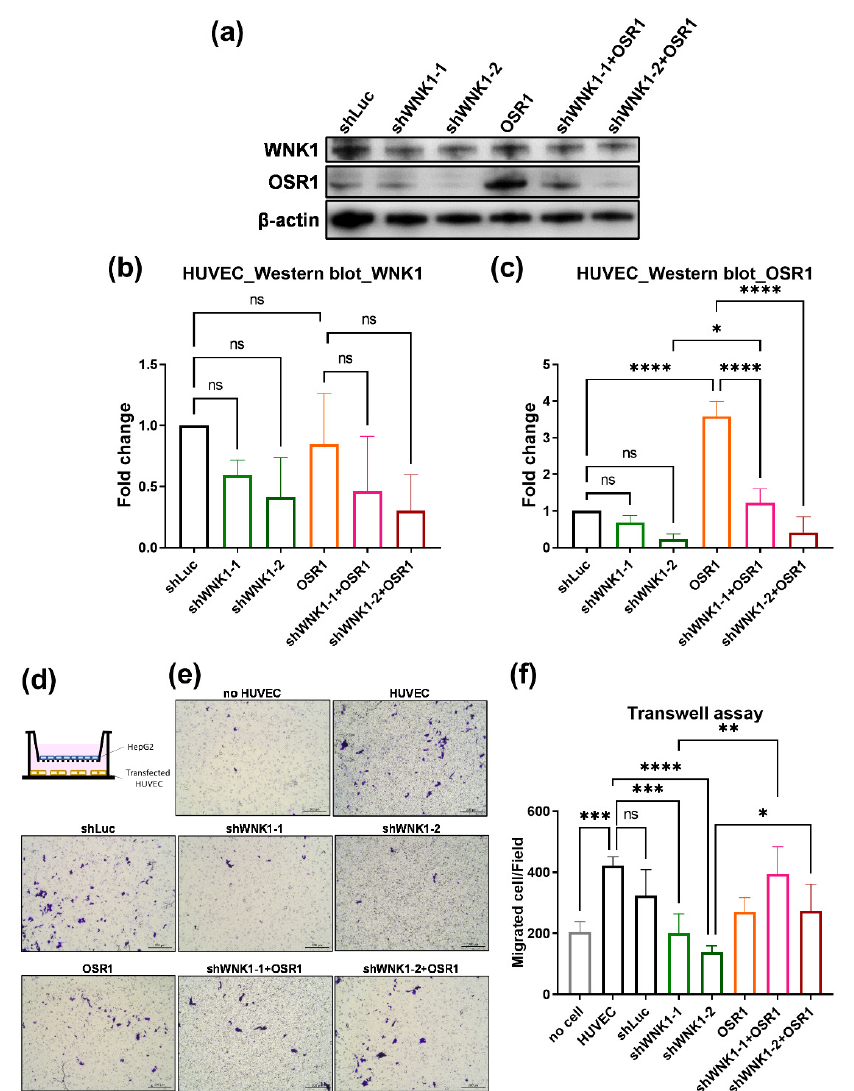
Figure 8. Knockdown of WNK1 in HUVEC cells significantly decreases the co-cultured hepatoma cell migration, and OSR1 overexpression can rescue the reduced cell migration caused by shWNK1 knockdown in endothelial cells. ( a ) The protein levels of WNK1 and OSR1 with WNK1 knockdown and/or OSR1 overexpression in HUVEC cells were detected by Western blot. ( b ) Quantification of WNK1 Western blot indicated that knockdown WNK1 (shWNK1-1 and shWNK1-2) in HUVEC cells significantly decreases the WNK1 protein levels. ( c ) Quantification of OSR1 Western blot indicated that overexpression of OSR1 in HUVEC cells significantly increases the OSR1 protein level, knockdown WNK1 (shWNK1-1 and shWNK1-2) in HUVEC cells significantly decreases the OSR1 protein levels. ( d ) HUVEC cells modulated the expression of WNK1 and OSR1 and were seeded in the lower chamber while HepG2 hepatoma cells were loaded in the upper chamber of the transwell plate. ( e ) Representative images of hepatoma cell migration. The scale bar is 200 µ m in length. ( f ) Quantified data of the transwell migration assay shows that HUVEC cells with WNK1 knockdown significantly decrease the migrated hepatoma cells, indicating that WNK1 plays an important role in endothelial cells for stimulating hepatoma cell migration. Overexpression of OSR1 in shWNK1 knockdown HUVEC cells can revert the reduced hepatoma cell migration caused by shWNK1, indicating that OSR1 is downstream of endothelial WNK1 promoting hepatoma cell migration. We performed three replicates for each Western blot and transwell analysis. One-way ANOVA analysis followed by multiple analysis of variance was used to identify the statistical significance between groups. *: p (cid:53) 0.05; **: p (cid:53) 0.01; ***: p (cid:53) 0.001; ****: p (cid:53) 0.0001; ns: